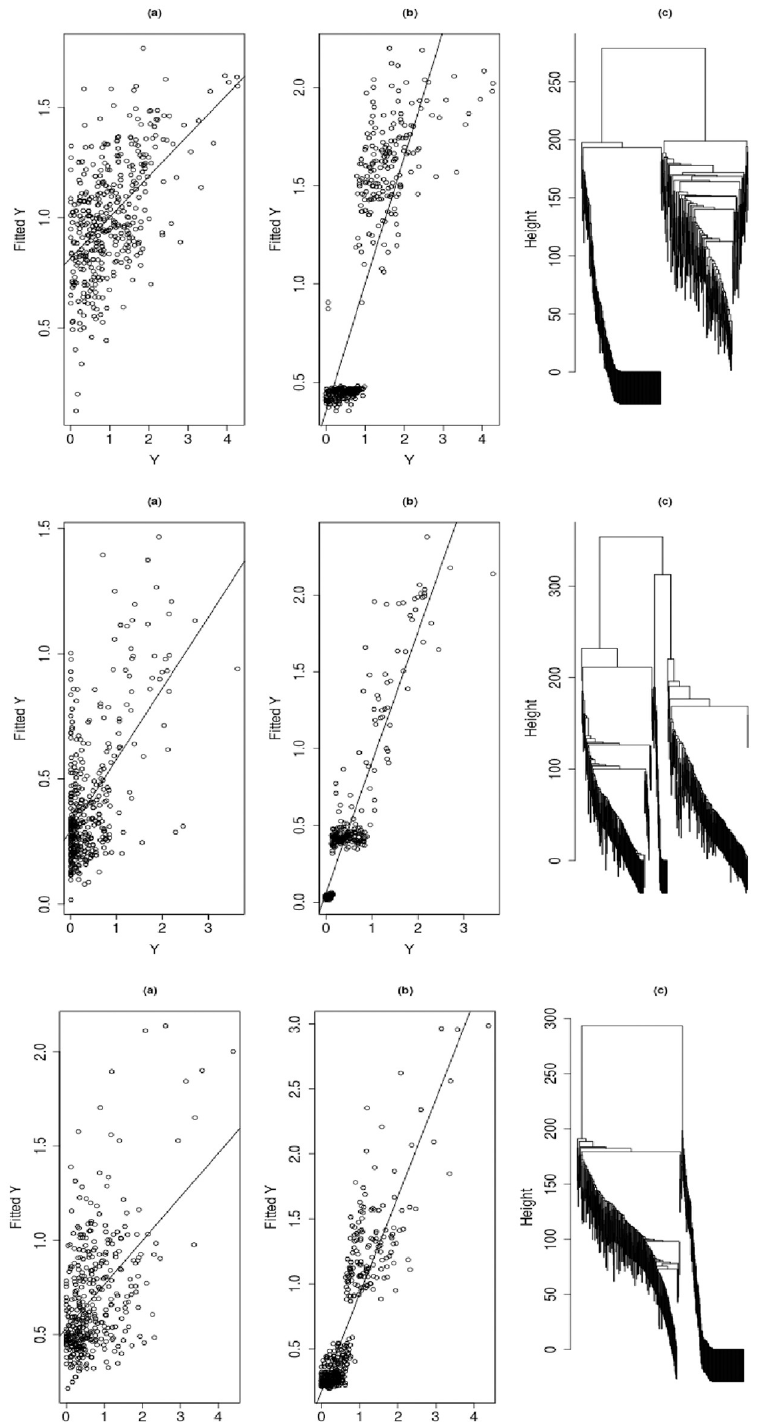
Fig 2. Comparison of the single component and mixture regression models for training data fitting. The left column is for the single regression model, the middle column is for the mixture regression model, and the right column is the cluster dendrogram produced by the mixture regression model; the top, middle and lower panels are for the drugs AZD0530, L-685458 and Lapatinib, respectively.